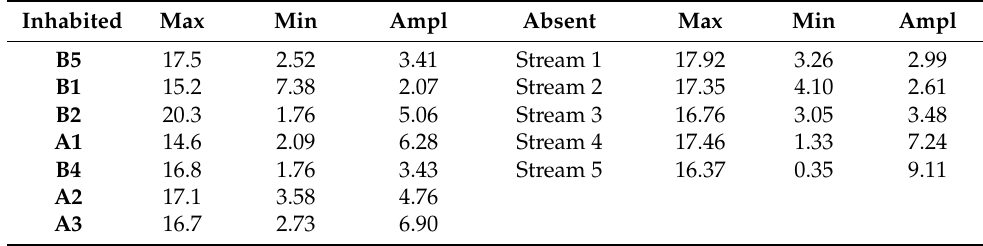
Females, x: 17.51 ◦ C, Range: 15.22 to 20.88) [33]. Table 1. Water surface temperature of some streams which C. arnoldi inhabits or where it is absent. Max: Maximal year temperature. Min: Minimal year temperature. Ampl: Average of daily thermic amplitude. Values are expressed in degrees centigrade. Data resumed from [17].